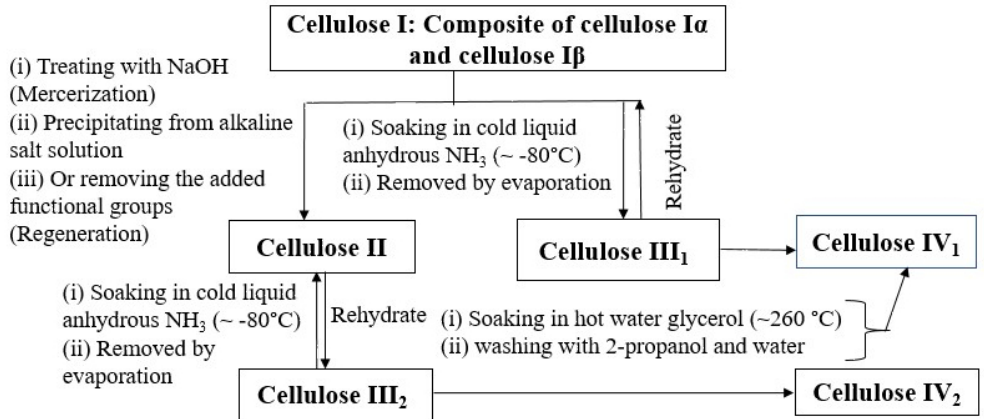
Figure 2. Illustration of interconversion of cellulose I and cellulose II into other cellulose allo- morphs